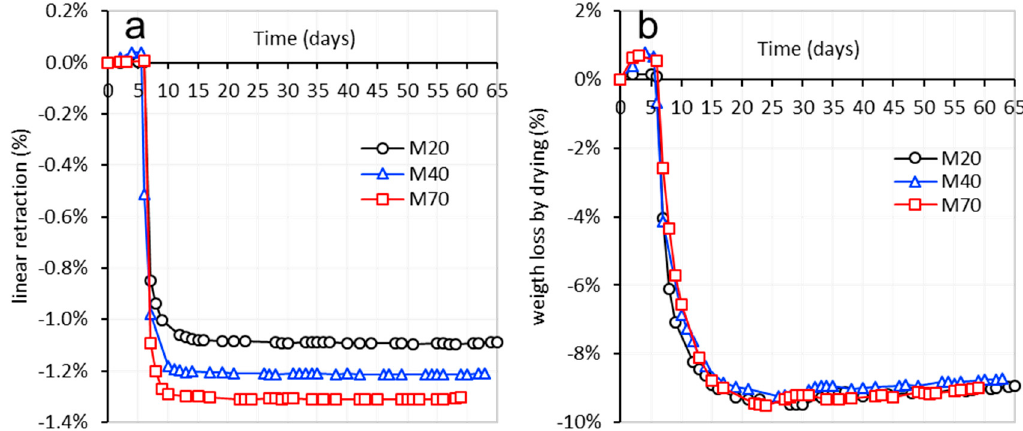
Figure 4. Shrinkage and weight loss over time in all types of activated mortars. ( a ) Linear retraction, and ( b ) weight loss.